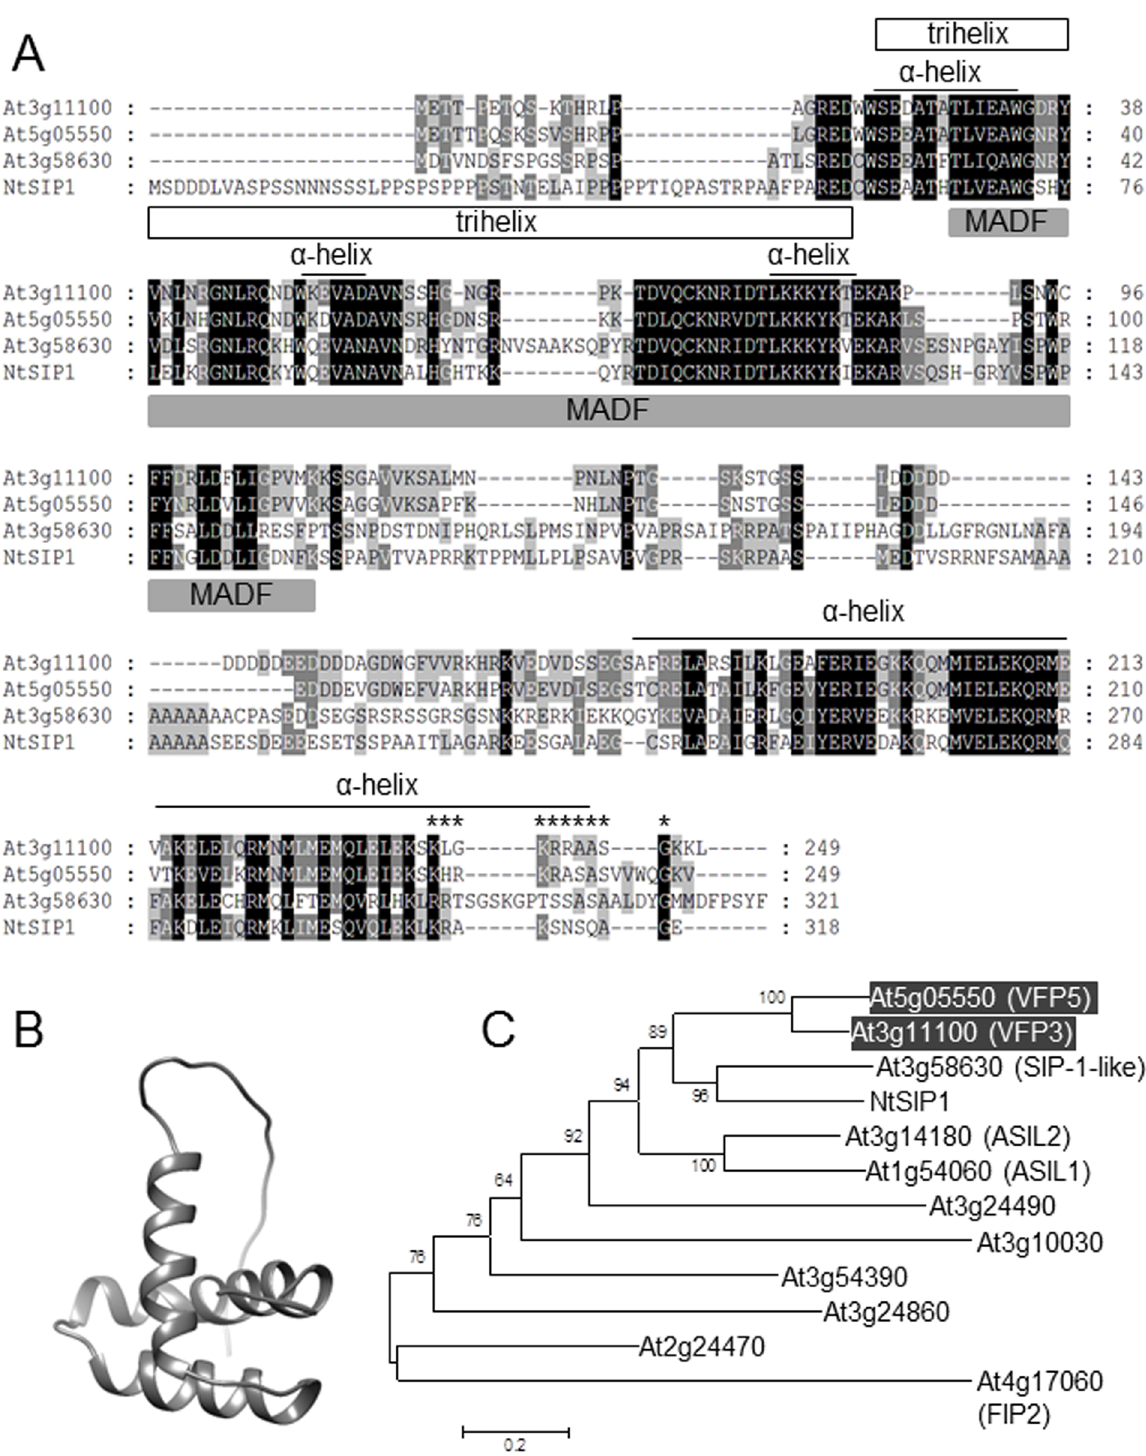
Fig 3. Amino acid sequence analysis of VFP3. (A) Sequence alignment of VFP3 and its homologs from Arabidopsis. The deduced amino acid sequence of VFP3 (At3g11100) was aligned with the sequences of proteins encoded by At5g05550 (VFP5) and At3g58630 of Arabidopsis and of tobacco NtSIP1 (GenBank accession number BAB83610.1) using ClustalX (ver. 2.1) (http://www.clustal.org/clustal2/). Three α -helices of the trihelix domain, delineated with an open box, and the fourth C-terminal α -helical region were predicted using the Garnier-Robson-Osguthorpe (GOR) algorithm [26]. The MADF domain, predicted by InterPro (http://www.ebi.ac.uk/interpro), is delineated with a gray box. Asterisks indicate the putative monopartite NLS predicted by cNLS